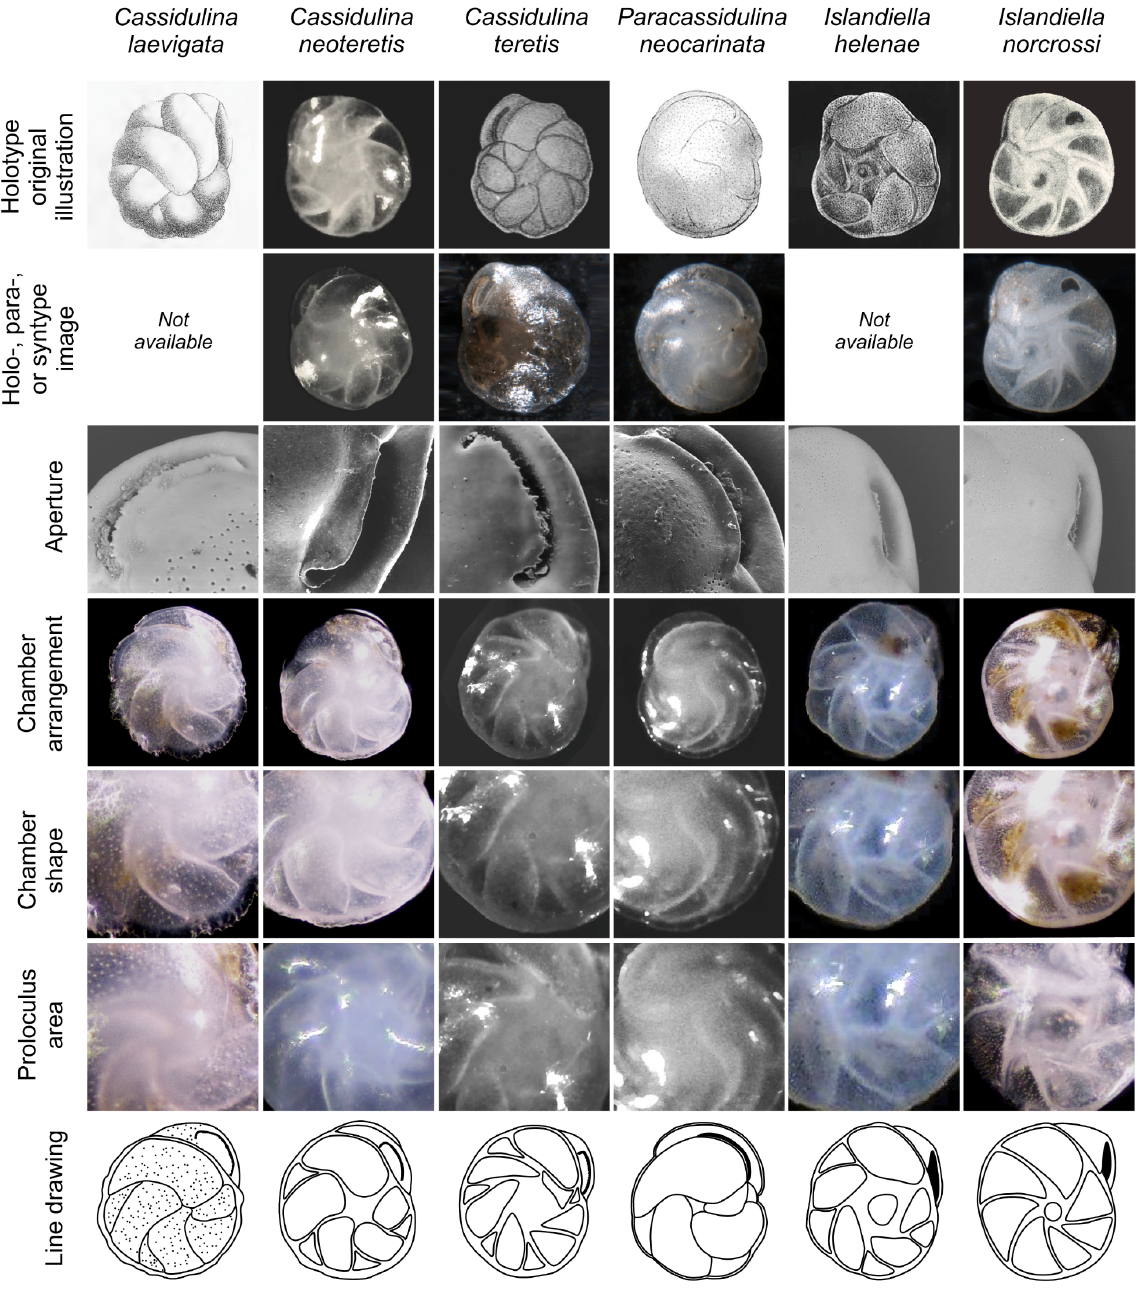
Figure 5. Annotated comparison of Cassidulina laevigata , Cassidulina neoteretis , Cassidulina teretis, Paracassidulina neocarinata , Is- landiella helenae , and Islandiella norcrossi , including original illustrations of the holotypes and holo-, para-, or syntype re-images where available. Key features for separating these morphologically similar species are highlighted. Holotype original illustrations are repro- duced by permission from the Journal of Micropalaeontology ( C. neoteretis ), the Cushman Foundation for Foraminiferal Research ( C. teretis ), and the Smithsonian Libraries ( P. neocarinata , I. helenae , I. norcrossi ). Re-images for C. teretis (holotype), P. neocarinata (syntype), and I. norcrossi (holotype) are from the Paleobiology Collections of the Smithsonian National Museum of Natural History (https://collections.nmnh.si.edu/search/paleo/, last access: 19 October 2020) and are made available under the Creative Commons CC0 1.0 li- cence. A paratype image is provided for C. neoteretis from the material used in Seidenkrantz (1995). Line drawings in the bottom panel are based on original illustrations of holotypes and specimens examined for the present study. For sample details refer to Supplement Tables S1 and